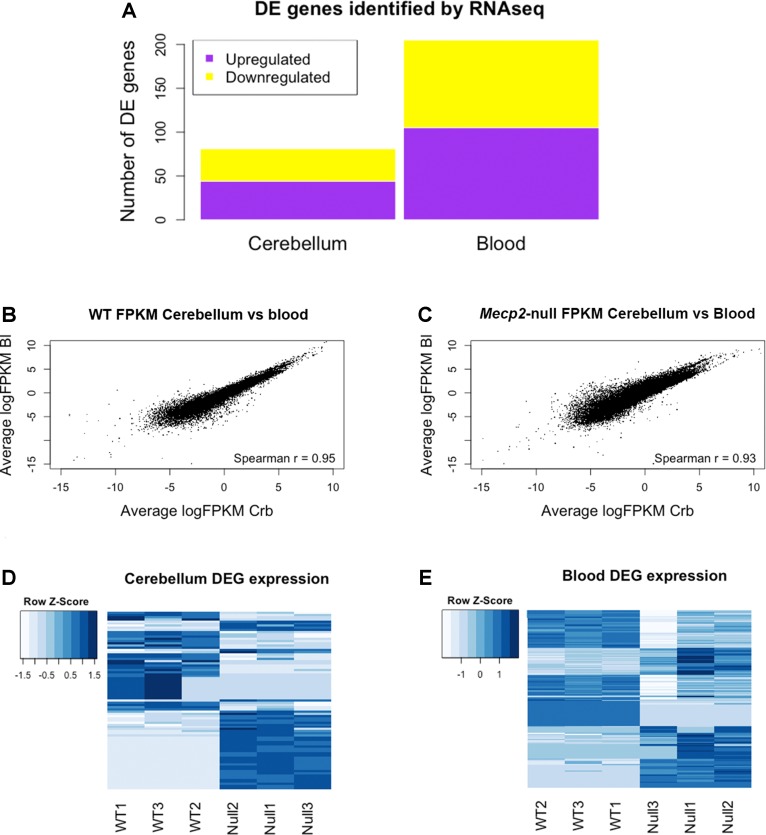
RNAseq analysis reveals differentially expressed genes (DEGs) in cerebellum and blood and identifies gene expression correlation between them. Summary of the Mecp2-null vs WT RNAseq analysis. (A) Number of DEGs identified in blood and cerebellum between Mecp2-null (N = 3) and WT mice (N = 3). 205 DEGs were identified in blood (105 upregulated and 100 downregulated), and 81 were identified in cerebellum (44 upregulated and 37 downregulated). For statistical comparison, we used EdgeR package with FDR correction and a significance level of p < 0.05. (B, C) Scatterplots of average gene expression in cerebellum versus average gene expression in blood, in logFPKM in WT (B) and Mecp2-null (C). (D, E) Heat maps of expression Z-scores (normalized FPKM values) of the DEGs identified in cerebellum and blood.